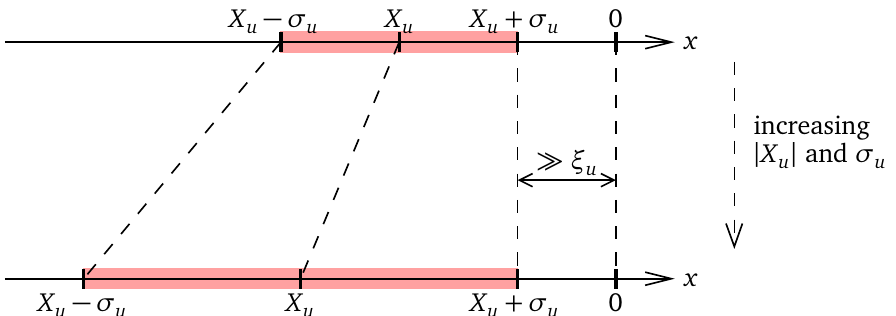
Figure 3: Schematic representation of the behavior of the parameters X ( x ) defined in Eq. (16). The shaded zone is the region where the window function function Π u notably differs from zero. The spacing between X and this ensures that the Fourier analysis, which is made local thanks to the window function, is performed in the deep subsonic